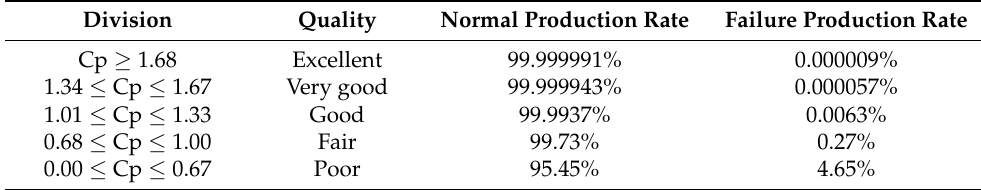
Table 1. Criteria of process capability, Cp.